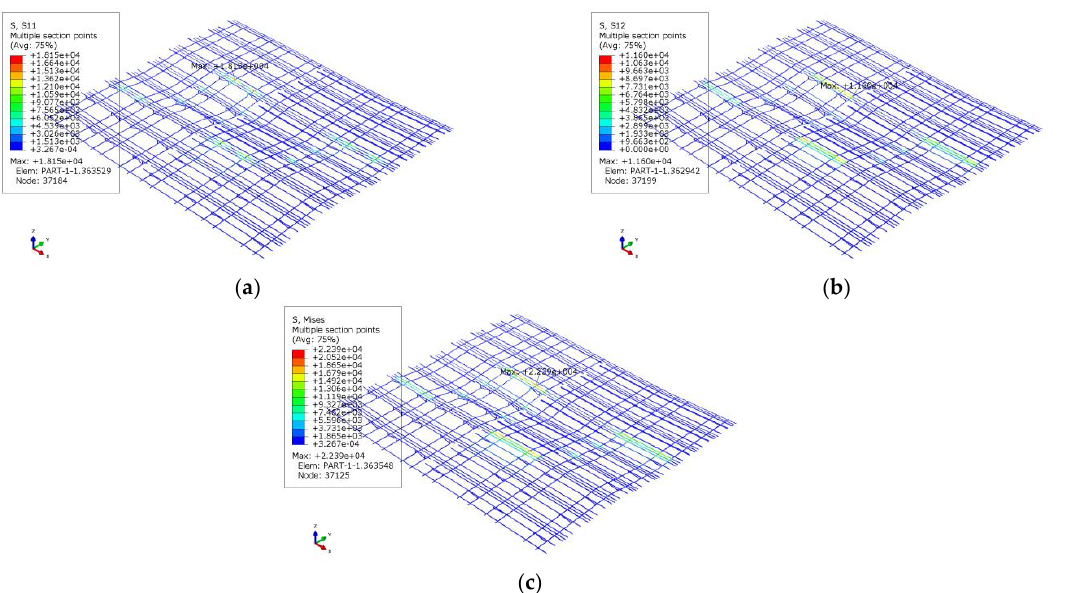
Figure 8. Stress distribution for the case M1-S1 (uneven mass and wave incident angle 0°): ( a ) normal stress; ( b ) shear stress; ( c ) von Mises stress.